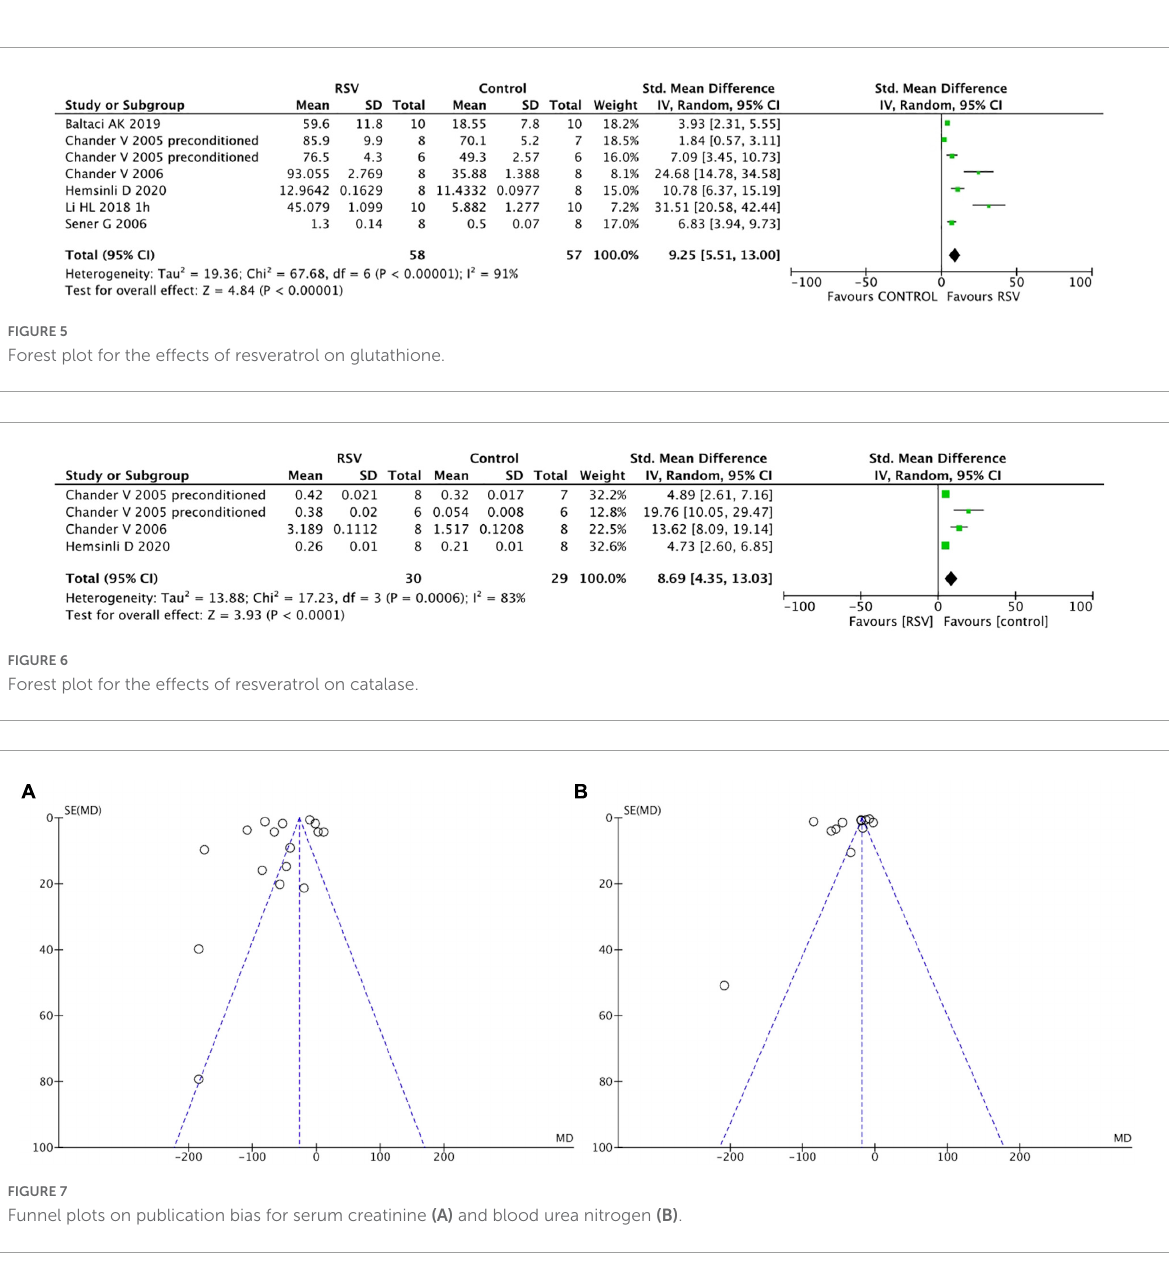
regulators of antioxidant cell defense, and impaired Nrf2-GST activity in the kidney, thus mitigating renal inflammation and injury (48). Besides, RSV was also reported to scavenge ROS directly